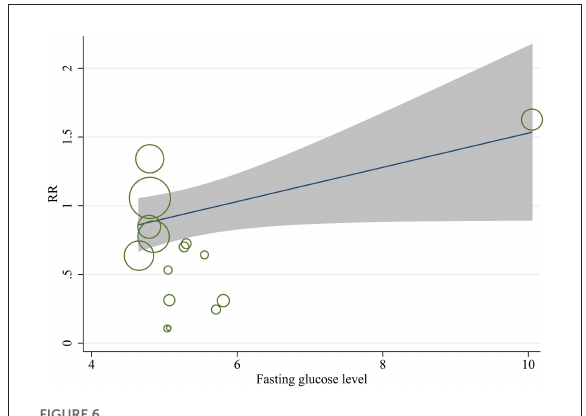
FIGURE6 Meta-regression model for the effect of prenatal lifestyle intervention on the risk of neonatal hypoglycemia, adjusted for maternal fasting blood glucose levels at